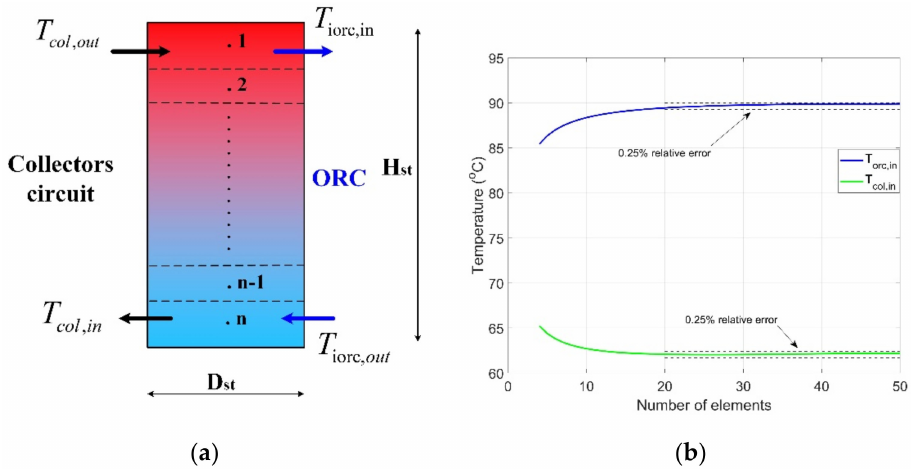
Figure 2. ( a ) Schematic of the storage tank’s discretization methodology; ( b ) overview of the influence of the number of mixing zones on the stability of the